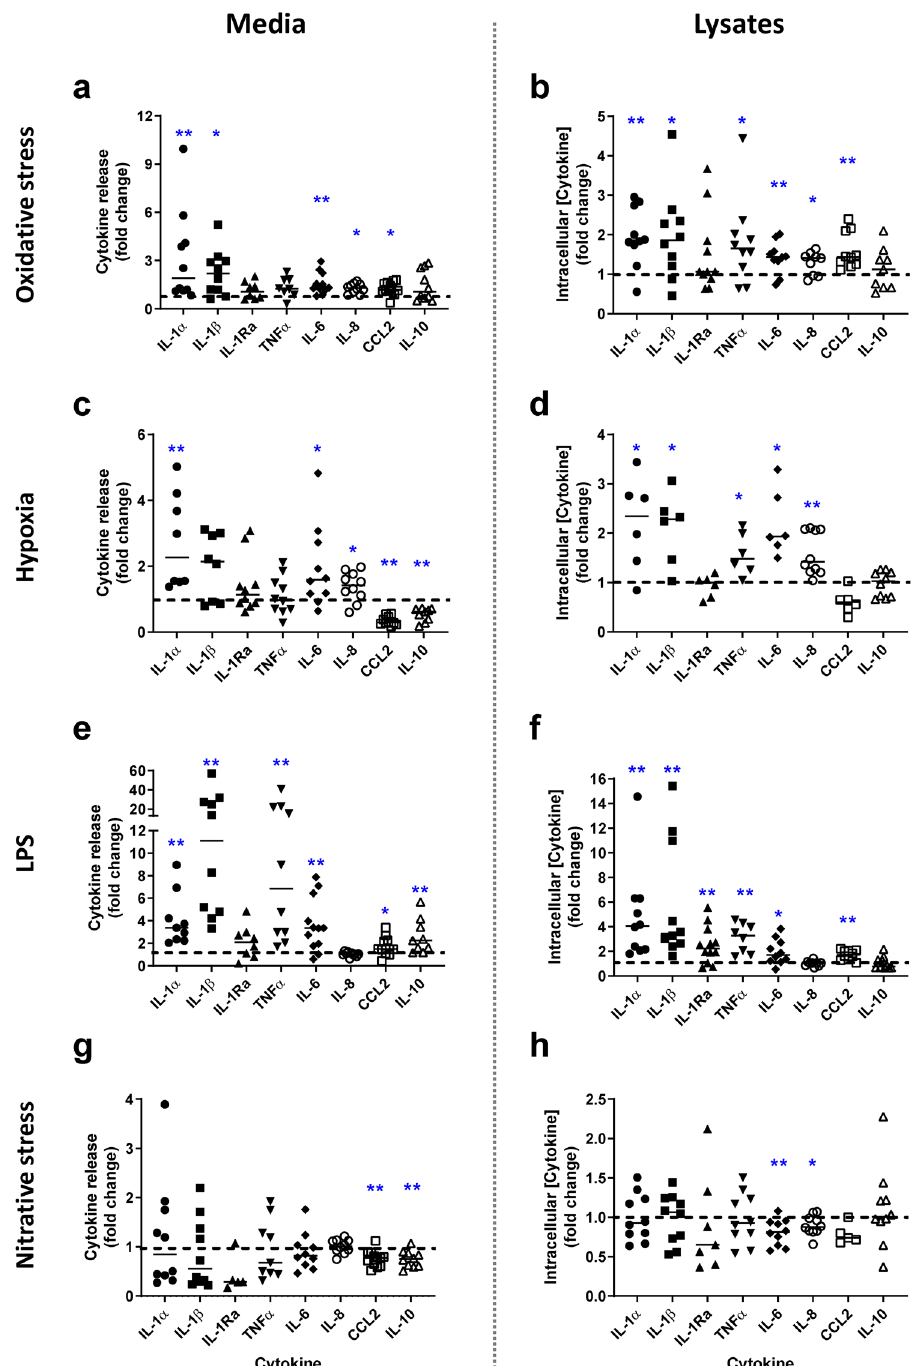
Figure 3. Effect of insults on term placental explant cytokine release and intracellular concentrations. Explants were exposed to ( a and b ) oxidative stress (1 mM H 2 O 2 ), ( c and d ) hypoxia (1%O 2 ), ( e and f ) low dose LPS (1 ng/ml to mimic subclinical infection), ( g and h ) nitrative stress (1 mM SIN-1) or media alone for 72 h. Concentrations of interleukin (IL)-1α, IL-β, IL-1Ra, tumour necrosis factor α (TNFα), IL-6, IL-8, CCL2, IL-10 were measured in culture medium and placental lysates by ELISA and corrected for explant protein content. Data are fold change from control conditions (n = 5–12, line represents median); dashed line represents control values. * p < 0.05, ** p < 0.01 Wilcoxon signed rank